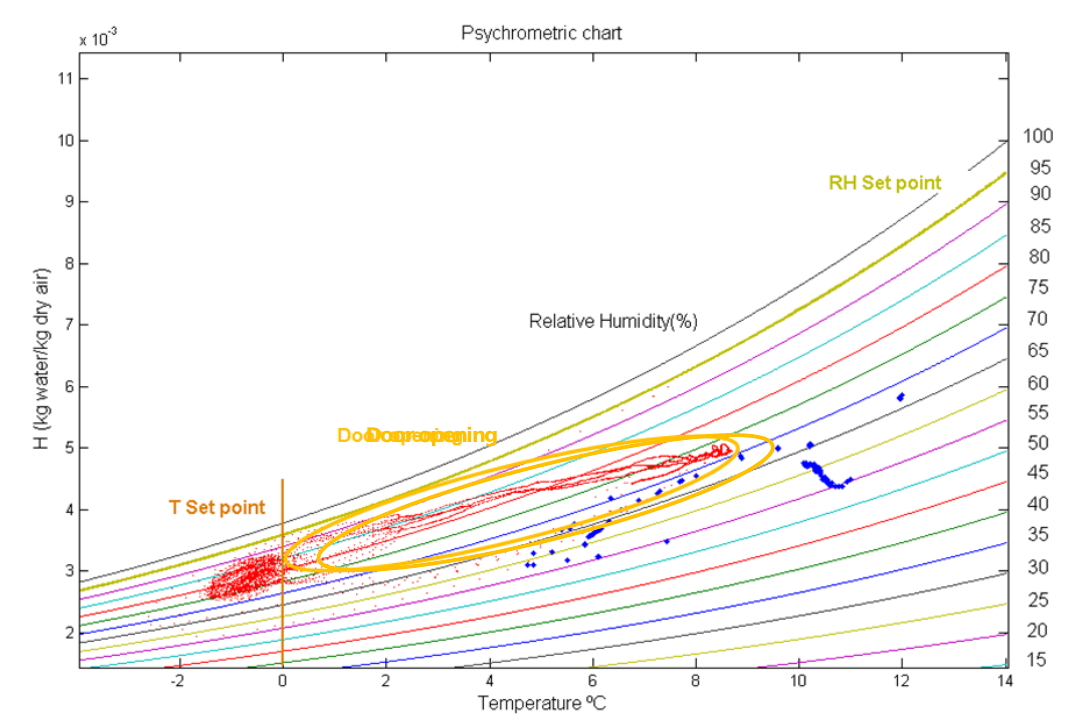
Figure 7. Psychrometric chart (color lines indicate relative humidity; red dots represent mote 4 and blue dots mote